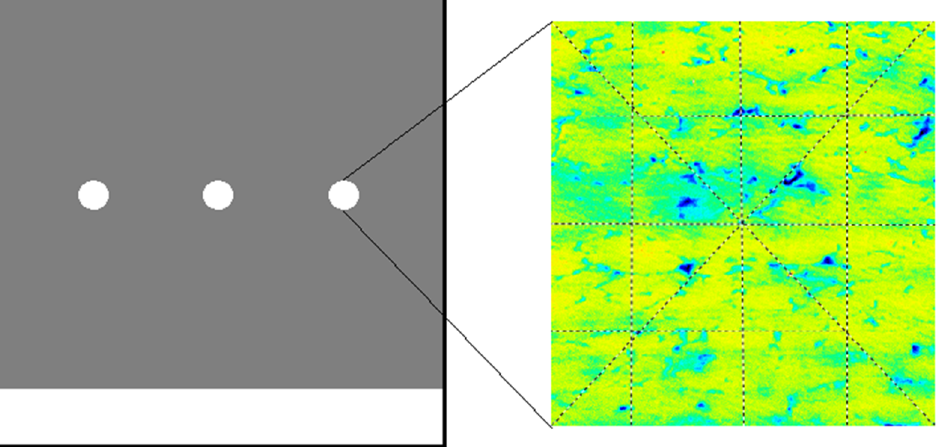
Figure 1. Representation of 8-line and 3-point profiled scanning configuration (highlighted in white) for each sample.